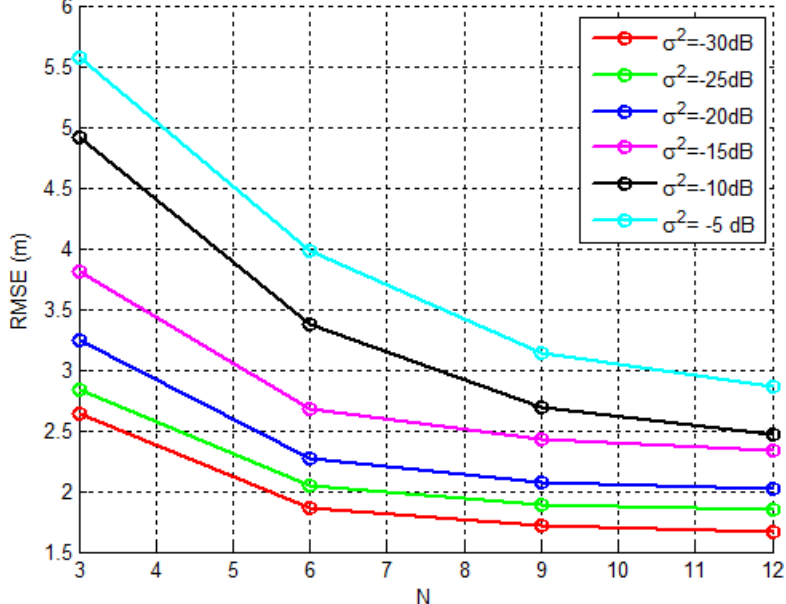
(dB) performance comparison for N = 12. i